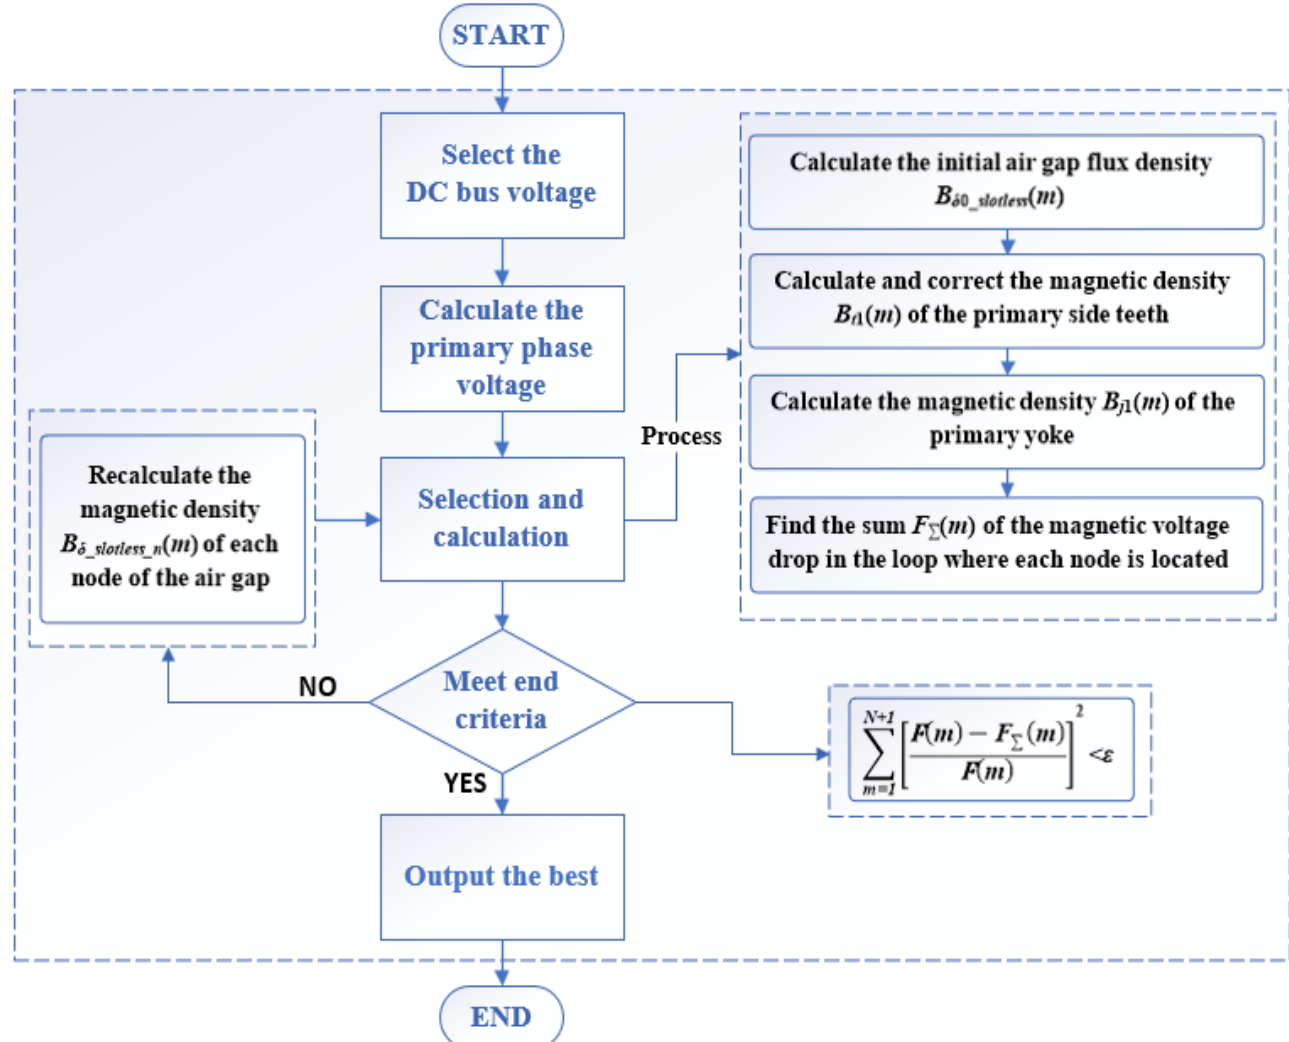
Figure 4. The iterative flowchart of the UP-LPST based on the DMCM. By extending the DMCM to the LPST, the magnetic field distribution of the air gap and iron core yoke could be obtained. This paper only describes the air gap in detail. The final result is shown in Figure 5: